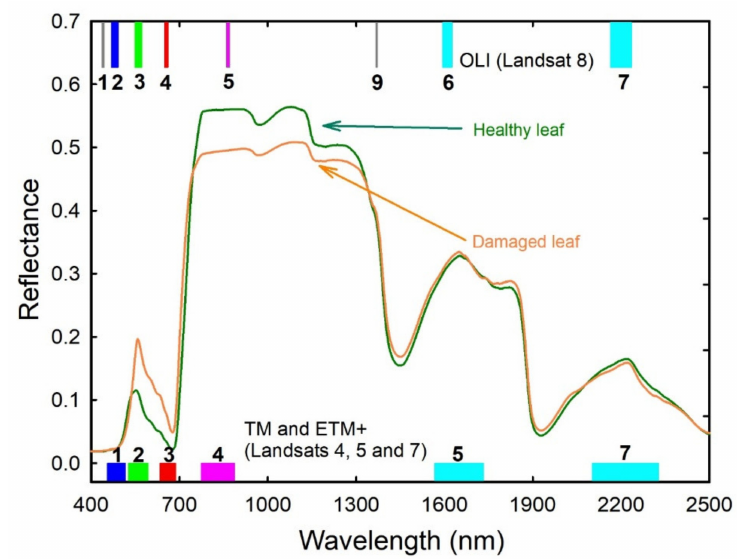
Figure 3. Simulated spectral reflectances of coconut palm leaves using the PROSPECT model. Along the bottom, sensor band number and wavelengths are shown for the Thematic Mapper (TM) and Enhanced Thematic Mapper Plus (ETM + ) sensors, and along the top for the Operational Land Imager (OLI). Exact wavelengths are shown in Table A2. Because parameterization data for coconut palms were not available, these simulations were based on studies using healthy oil-palm leaves, along with leaves damaged by G. boninensis